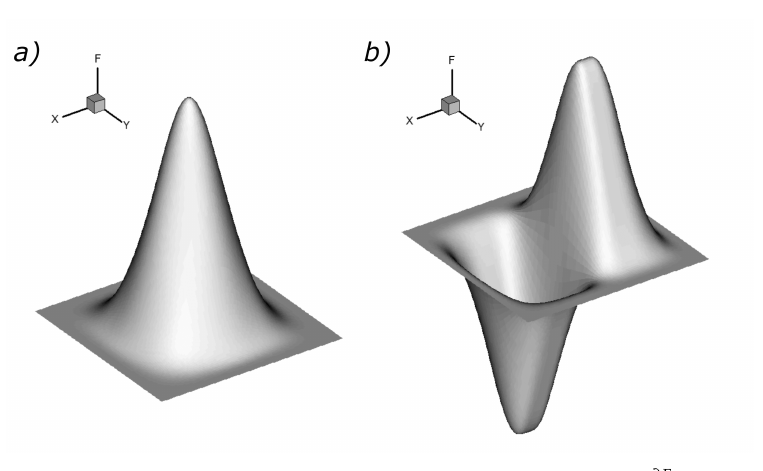
Figure 2. 2D Fup basis function F = Fup 1 ( x , y ) : ( a ) F ; ( b ) ∂ F